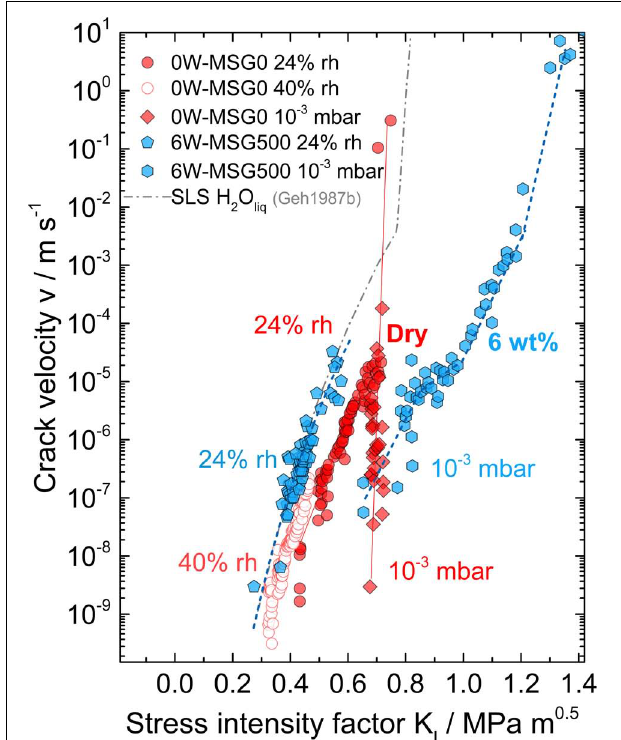
FIGURE 2 | Crack growth velocity, v , versus stress intensity factor, K I , for nominal dry (red) and hydrous microscope slide glass (6 wt% water, blue). Dashed blue line: guide for the eye. Red symbols and gray dash-dot curve (e.g. Gehrke et al., 1987b) are taken from Figure 1 . Blue pentagons: 20% rh, blue hexagons: 10 − 3 mbar ( ≈ 0.00002%